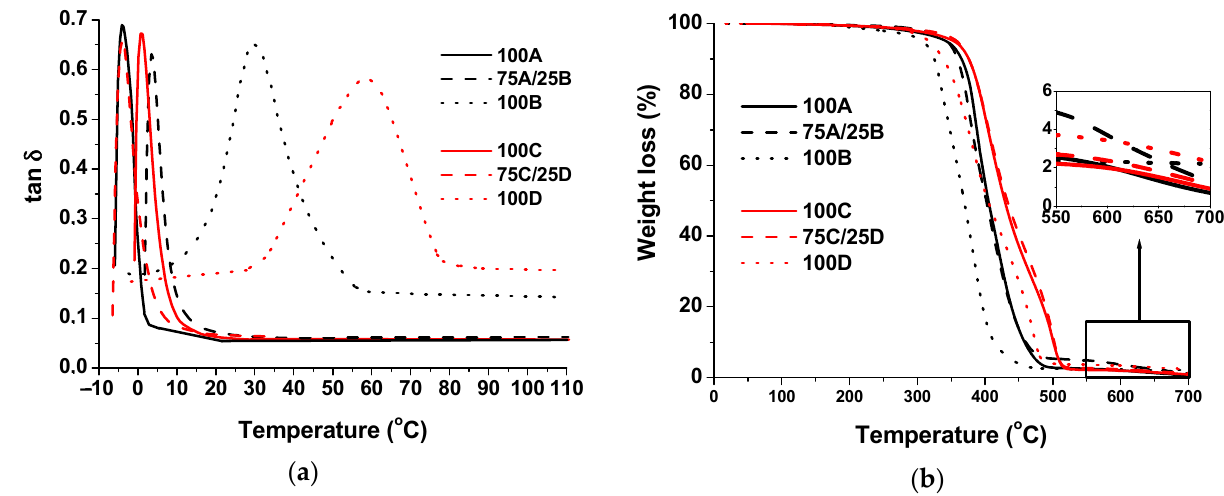
Figure 5. ( a ) Tan δ versus temperature curves of the cross-linked polymers; ( b ) Thermogravimetric curves of the cross-linked polymers.